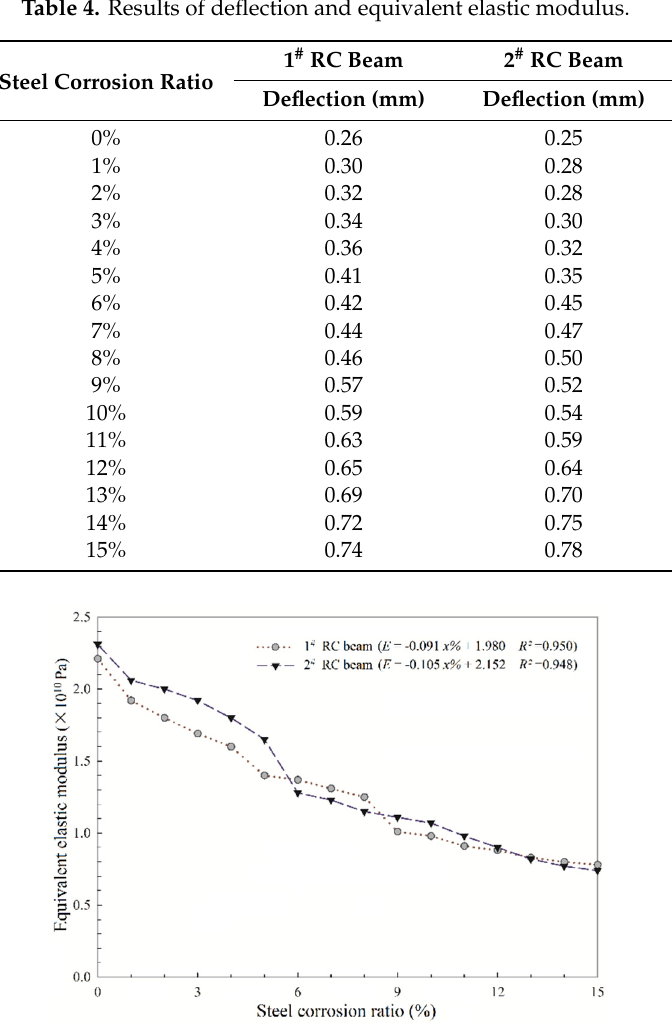
Table 4. Results of deflection and equivalent elastic modulus.